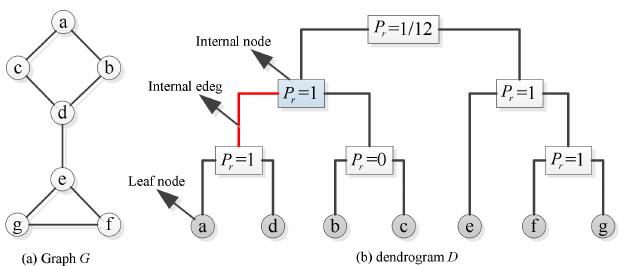
Figure 2. A sample network and hierarchical random graph composition. ( a ) A small sample network with seven vertices. ( b ) The structure of the hierarchical random